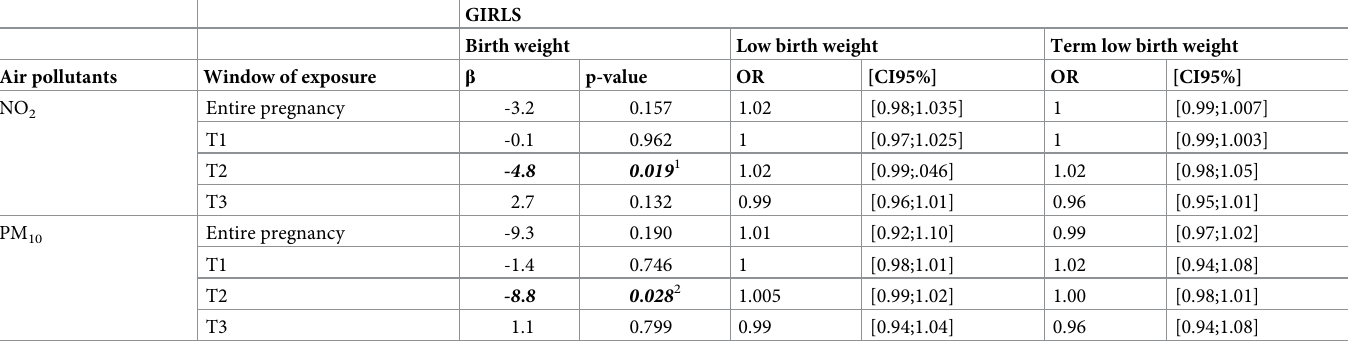
Table 3. Measures of associations and p-value (or 95% confidence interval) for 10 μ g/m 3 increase in concentrations of air pollutants by trimesters of pregnancy from regression models (defined as model 1 in §Material and methods) adjusted for individual covariates for girls. GIRLS Birth weight Low birth weight Term low birth weight Air pollutants Window of exposure